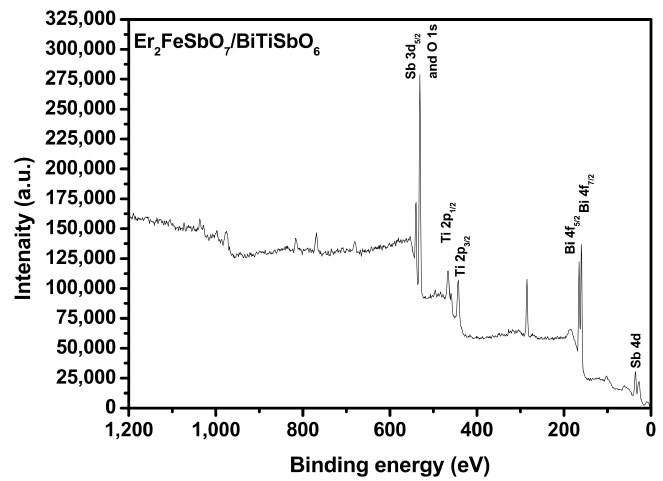
Figure 7. The XPS survey spectrum of the EBHP after the